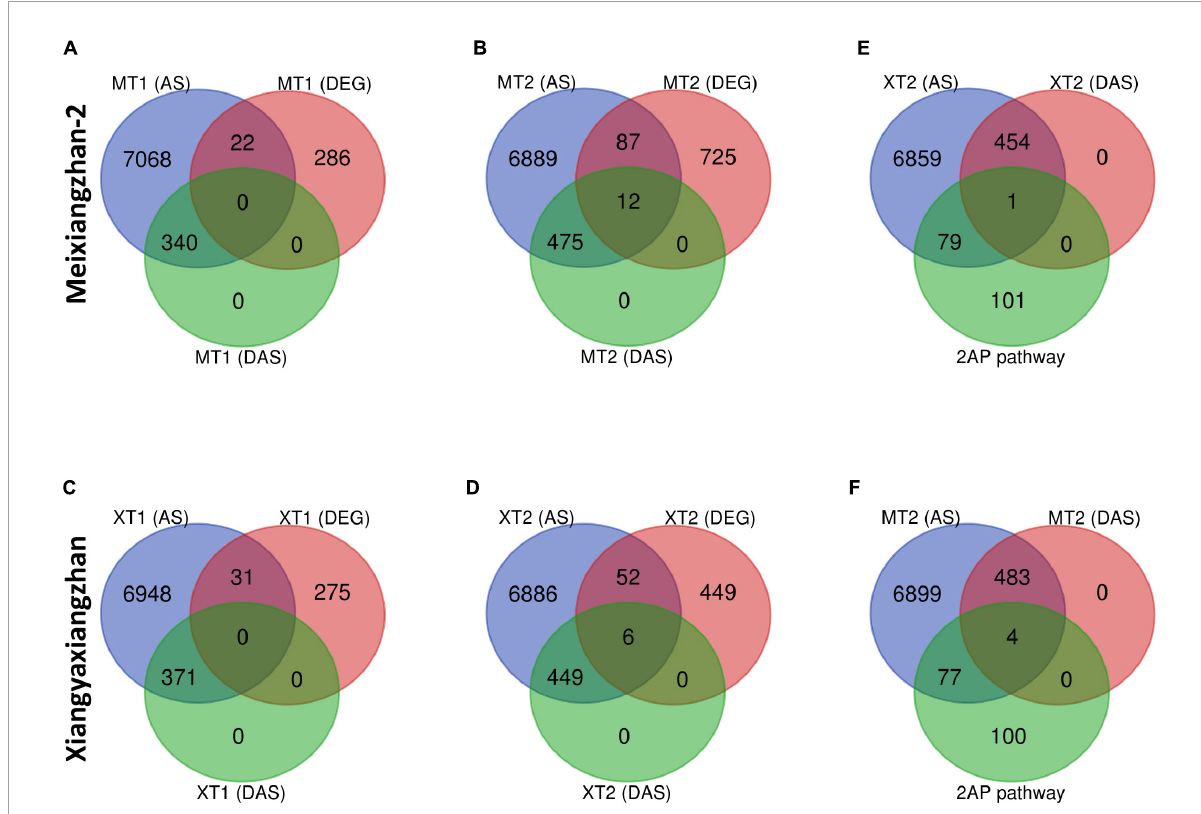
FIGURE5 Overlap of differentially alternative spliced (DAS) events with differentially expressed genes (DEGs) in Meixiangzhan-2 (M) and Xiangyaxiangzhan (X) cultivars in response to different levels of Zn treatment. Venn diagram representing the overlap between unique AS sites, DAS events and DEGs in response to different doses of Zn in Meixiangzhan-2 (A,B) and Xiangyaxiangzhan (C,D) in response to different doses of Zn treatment. (E,F) Venn diagram representing the overlap between unique AS sites, DAS events and 2-AP biosynthesis pathway-related genes in Meixiangzhan-2 and